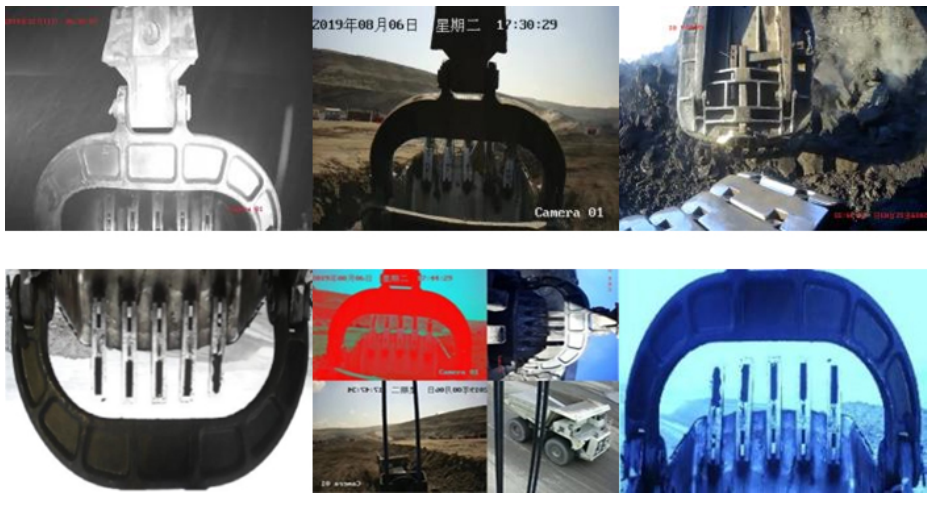
Figure 8. Dataset examples.